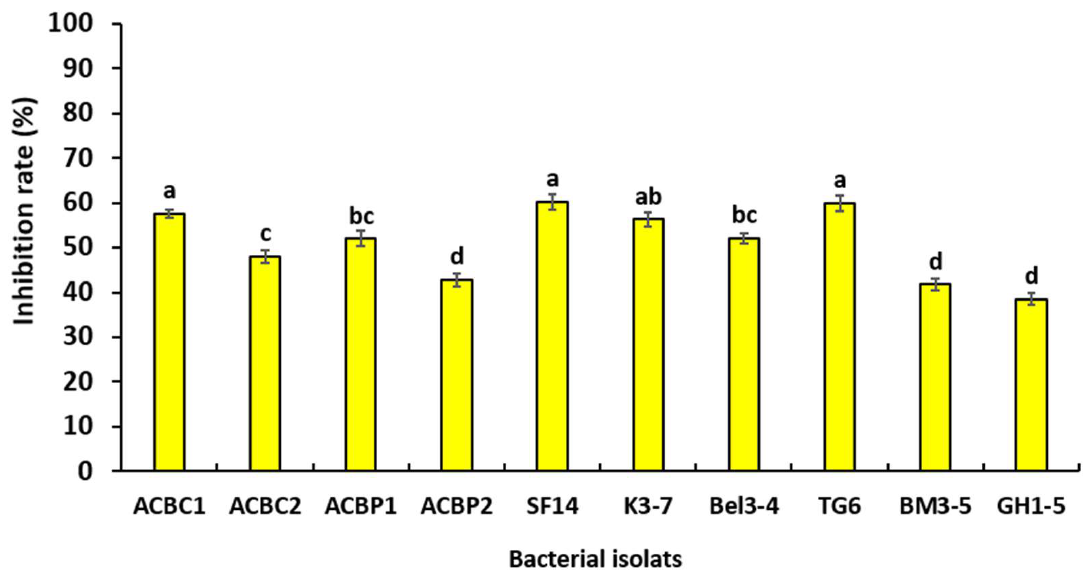
Figure 4. Effect of bacterial cell-free filtrates 10% v / v on the inhibition of mycelial growth of P. schmitthenneri after 6 days of incubation. Data in the figure represent the mean of two independent trials with 4 replicates. Treatments with the same letter were not significantly different according to the Tukey test ( p ≤ 0.05).